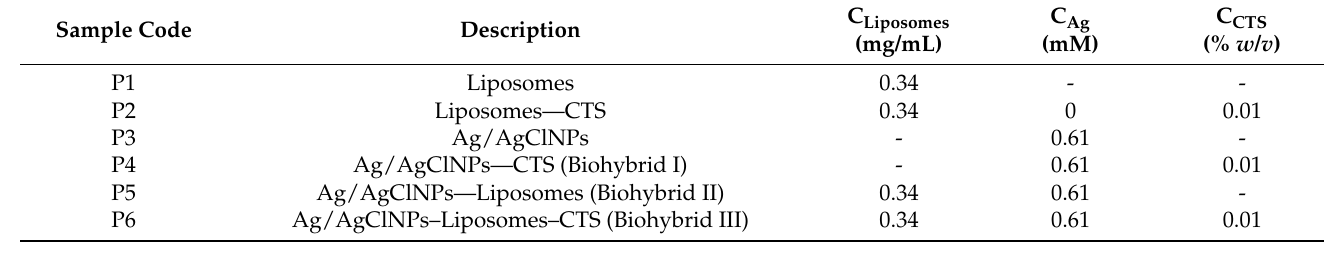
Table 1. Codes and descriptions of the samples.